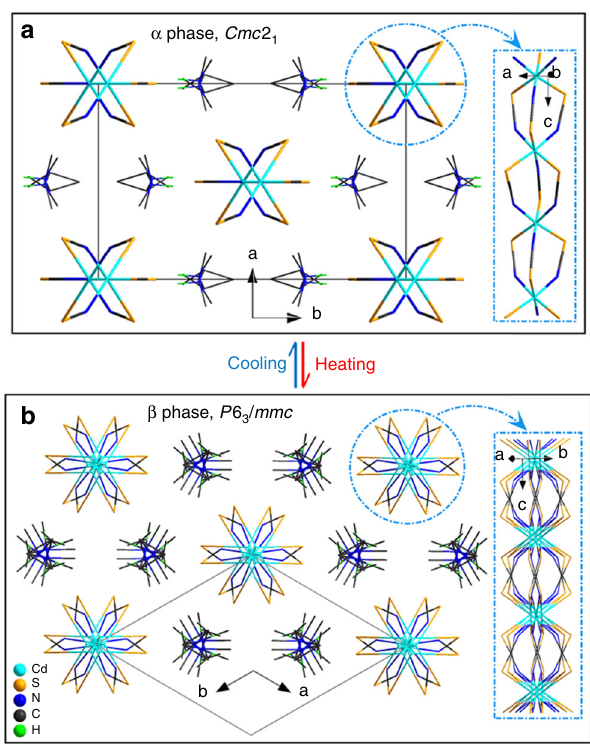
Fig. 5 Comparison of the crystal structures between 1 α and 1 β phase. a, b View of the packing structures of 1 α at 296 K and 1 β at 348 K. The disordered bonds are represented by thin lines. The C-bound H atoms have been omitted for